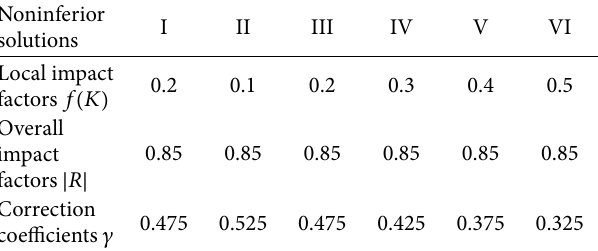
Table 4: The correction coefficient of weights.